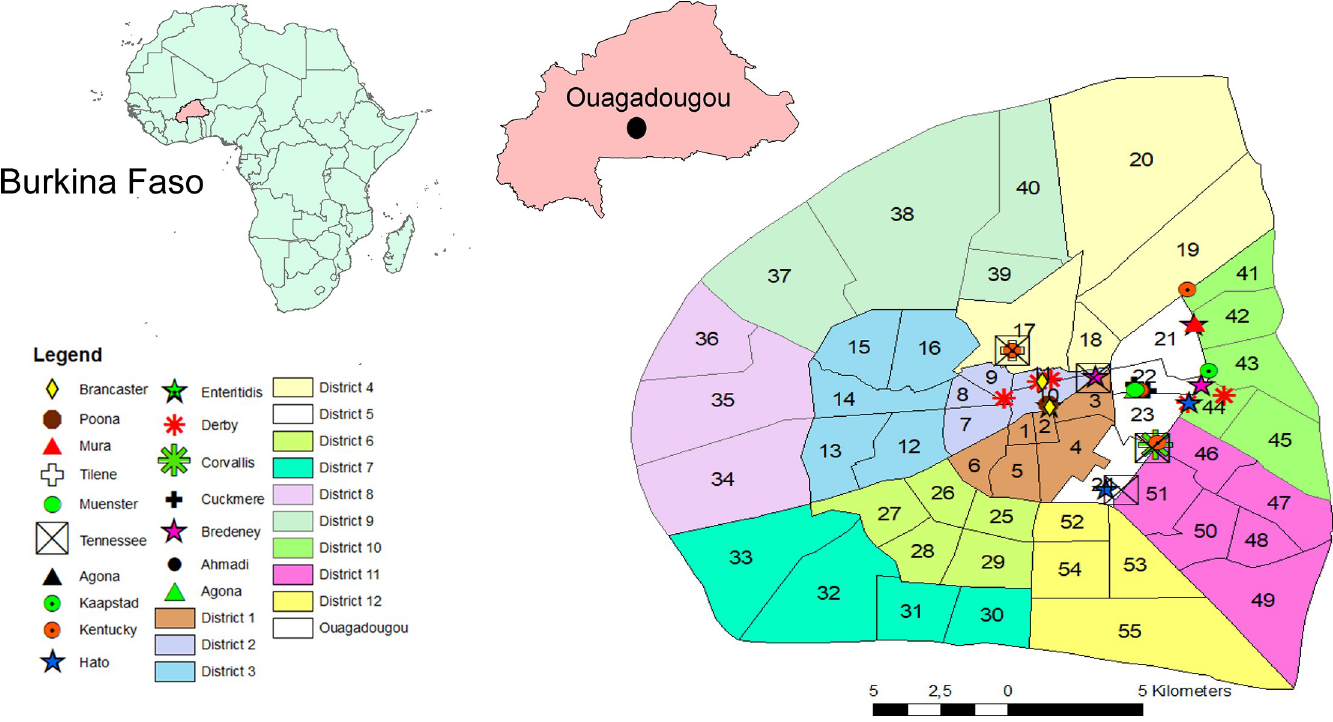
Fig 1. Geographic location of the various Salmonella serotypes identified in our study.